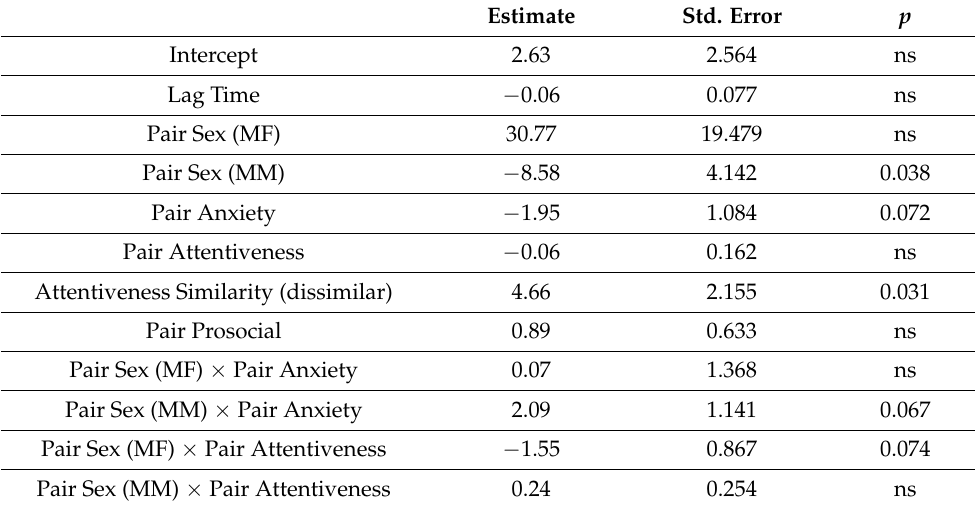
Table 4. Estimates from the logistic regression of the success of pair introductions following the Zoom